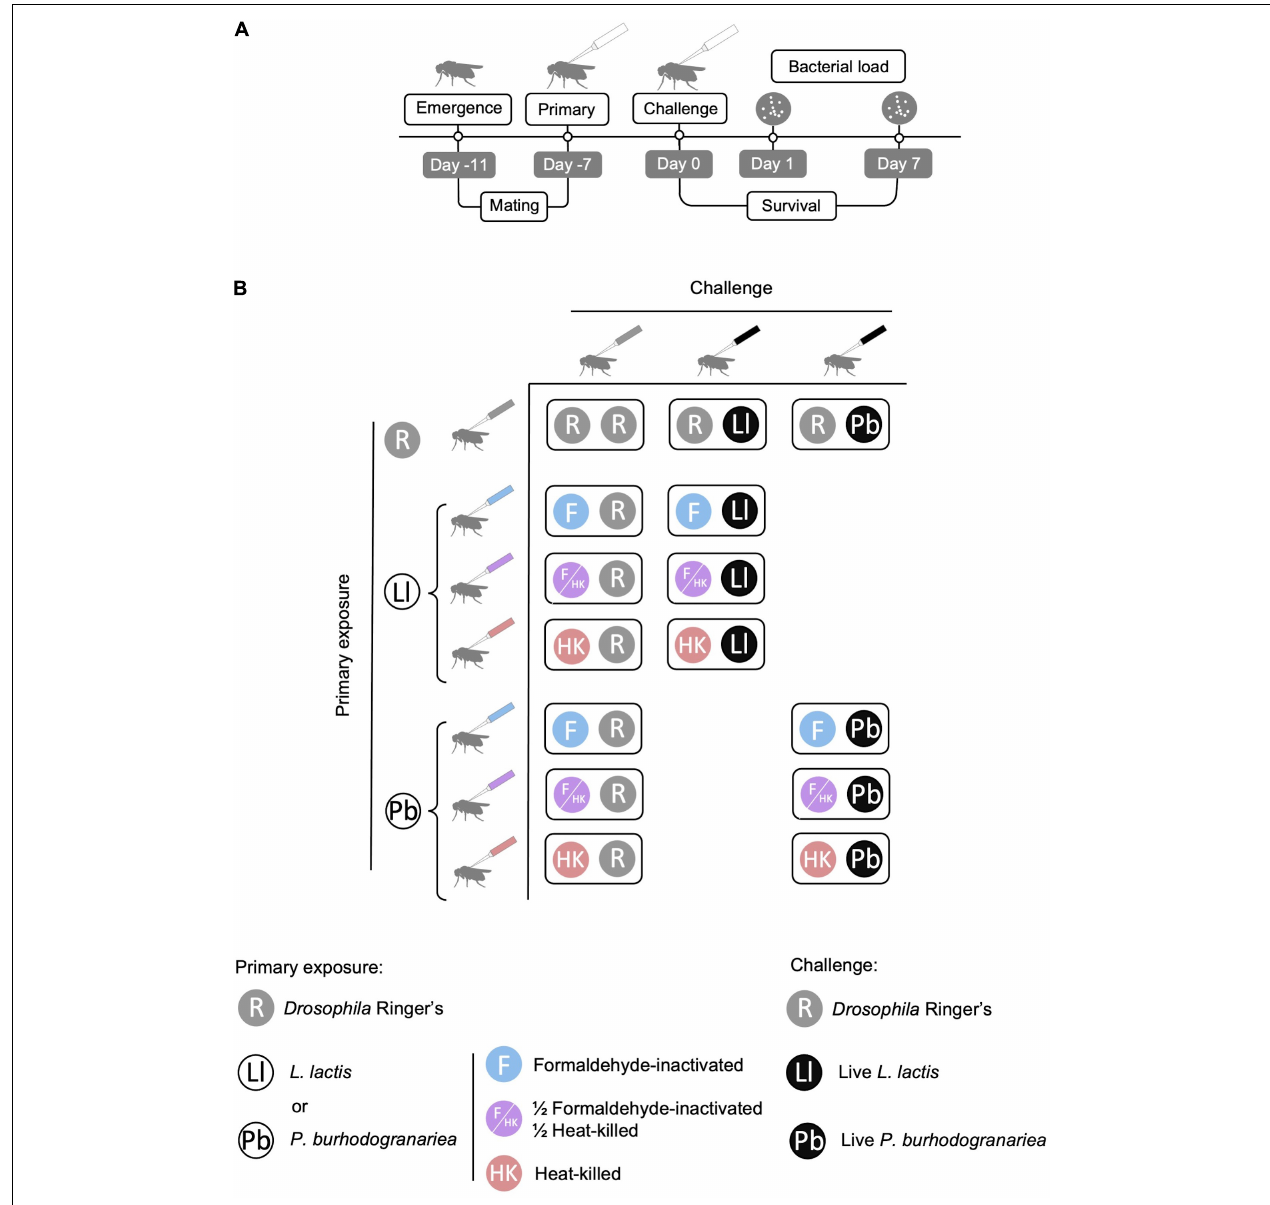
FIGURE 1 | Experimental design. (A) Timeline of the experiment with essential steps and assaying timepoints. Emergence refers to the time at which the adults eclosed. (B) Previous exposure and challenge treatment combinations used in the experiment. The primary exposure was either to Drosophila Ringer’s solution (R), Lactococcus lactis (Ll) or Providencia burhodogranariea (Pb). The primary bacterial exposure was either formaldehyde inactivated (F), a mixture of formaldehyde-inactivated and heat-killed bacteria (F/HK), or heat-killed bacteria (HK). For each primary exposure-challenge combination treatment flies were challenged with live bacteria; either 92 colony forming units (CFUs) of L. lactis or 920 CFUs of P. burhodogranariea . Figure adapted from Kutzer et al.